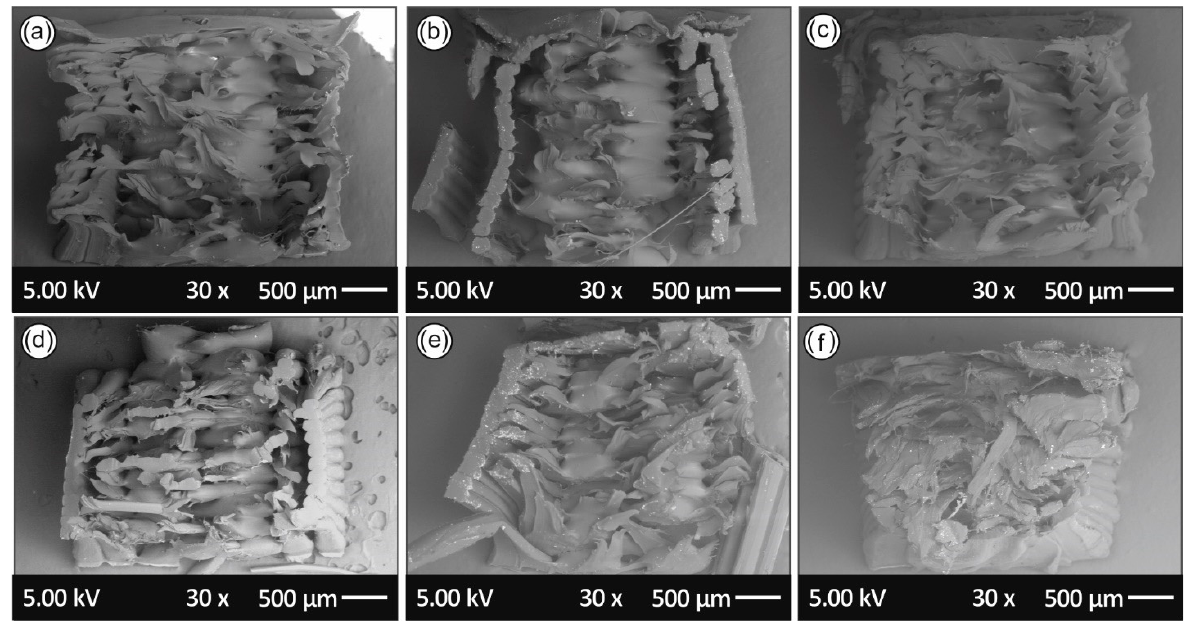
Figure 11. Tensile s pecimens’ fracture surface SEM images: ( a ) 1st recycling course, ( b ) 2nd recycling course, ( c ) 3rd recycling course, ( d ) 4th recycling course, ( e ) 5th recycling course and ( f ) 6th recycling course.